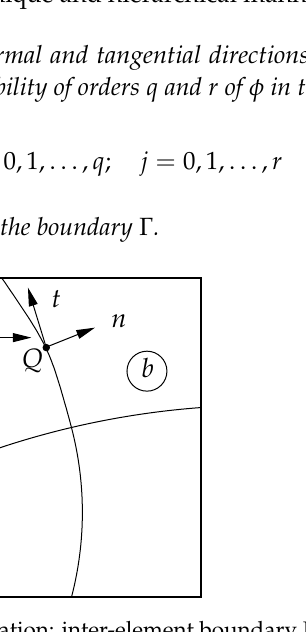
Figure 3. A four element discretization: inter-element boundary Γ between elements a (cid:13) and b (cid:13)